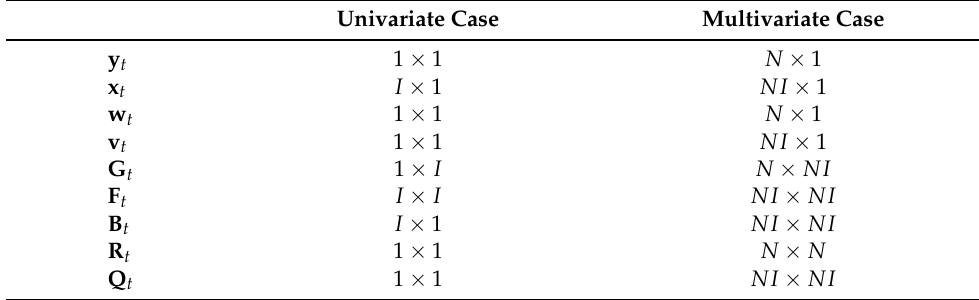
Table 8. Dimensions in the state space models of Hendrych and Cipra